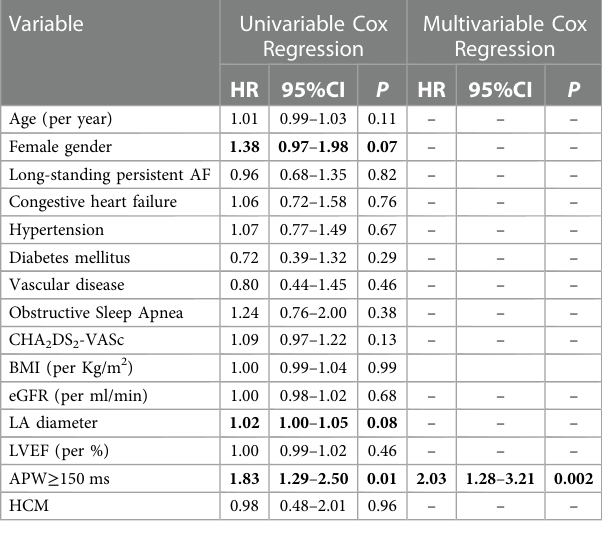
TABLE 2 Predictors of post-blanking atrial arrhythmia